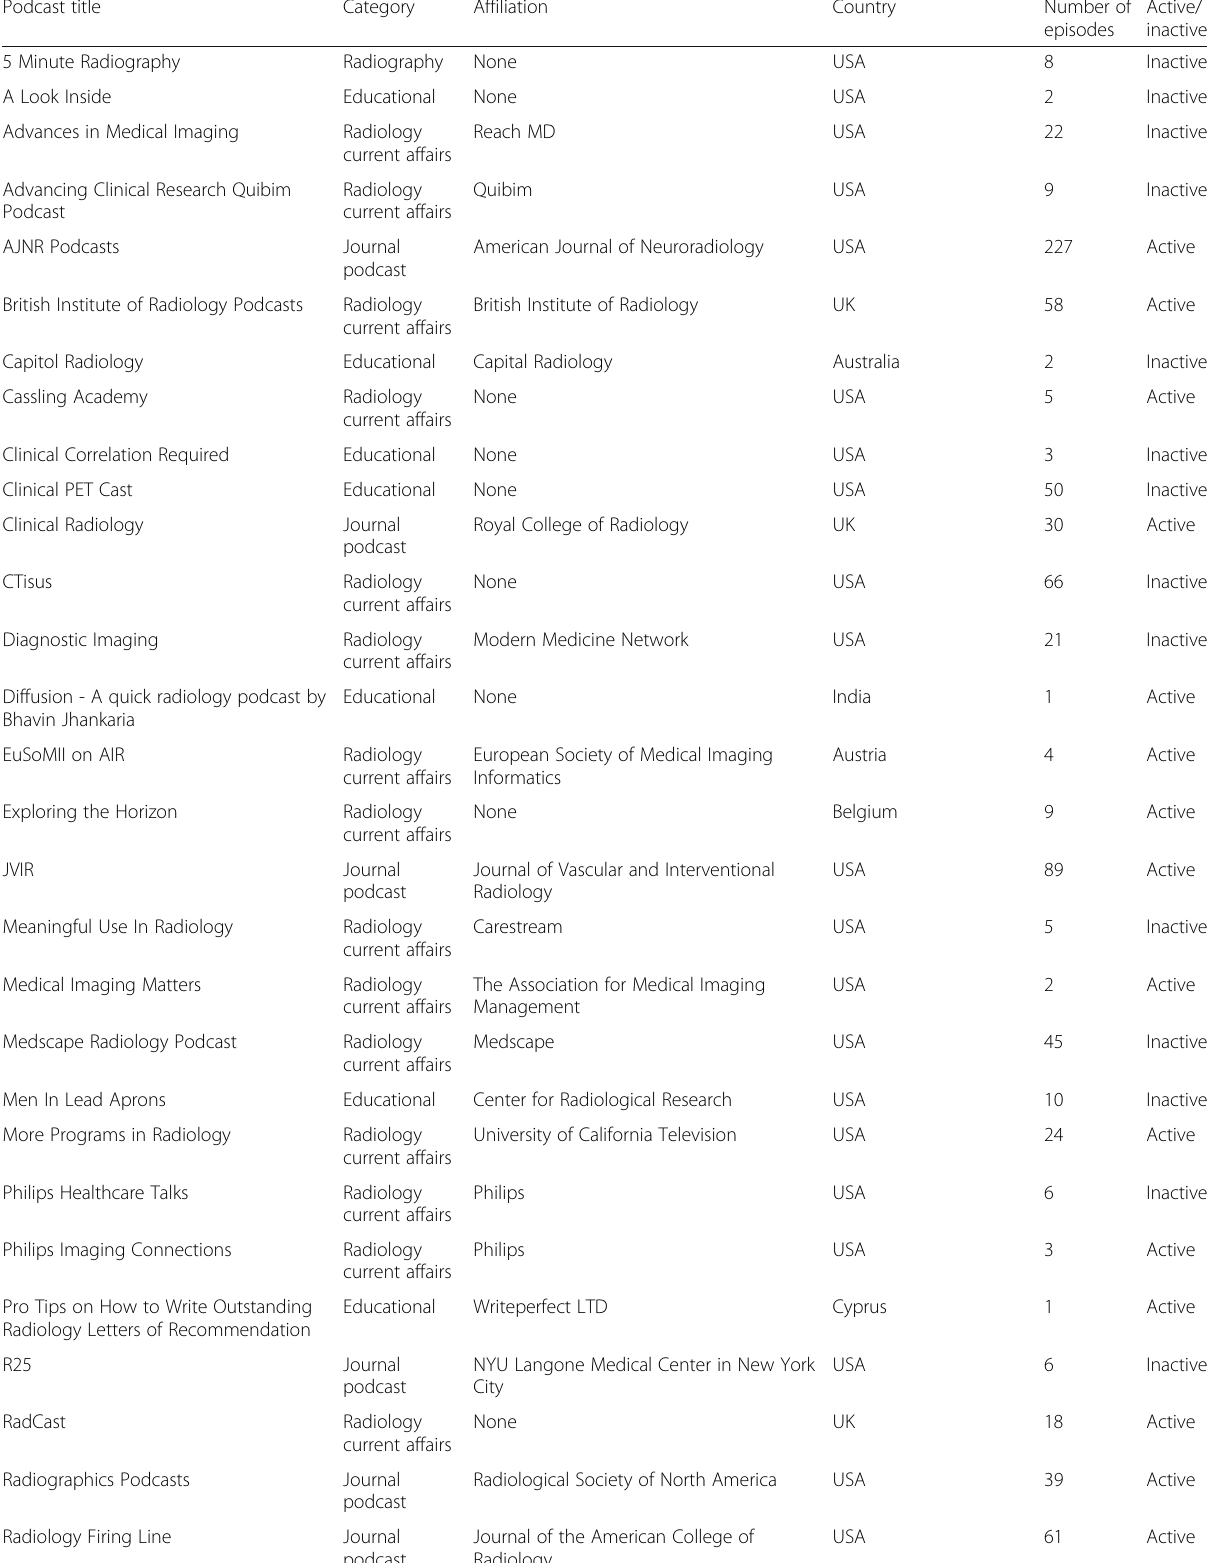
Table 3 Summary of radiology podcast series (data sampled 12 October